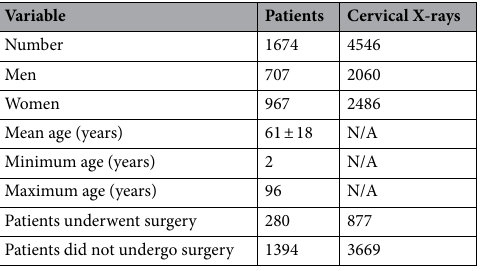
Table 1. Demographic data of study participants. N/A, not